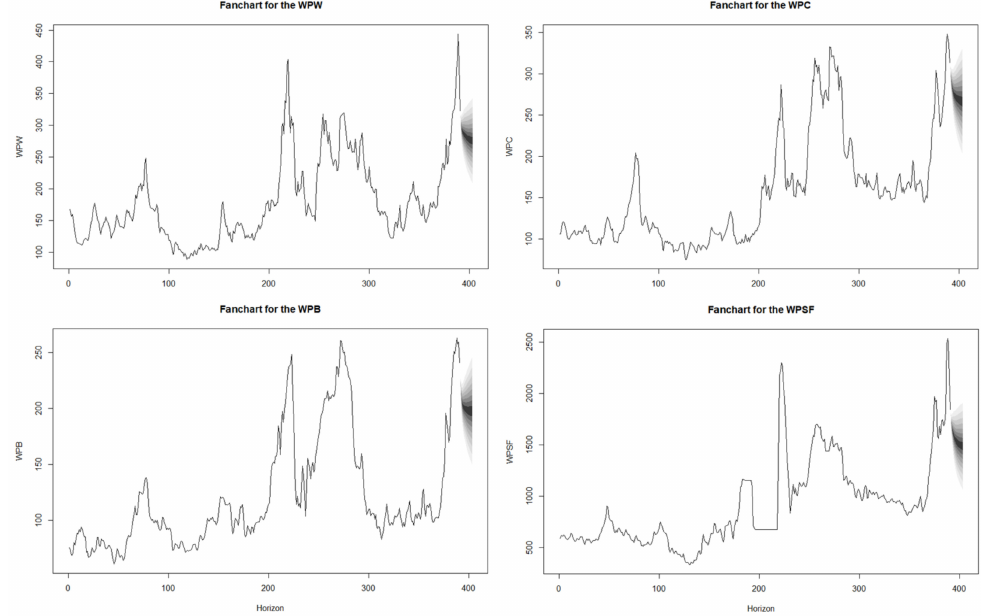
Figure 5. Estimated forecasts of the WPW, WPC, WPB and WPSF based on the VECM fanchart. Note: This figure presents the forecasts for the next ten months based on 391 observations of each variable in the model. The forecast starts on 1 July 2022 and ends on 1 April 2023 using raw data. Estimations were conducted through the VECM fanchart on a 95% confidence band. The black line represents estimated forecasts, and the shaded part in gray is the error margin. The figure was generated in R studio using the “forecast” package and the “fanchart”